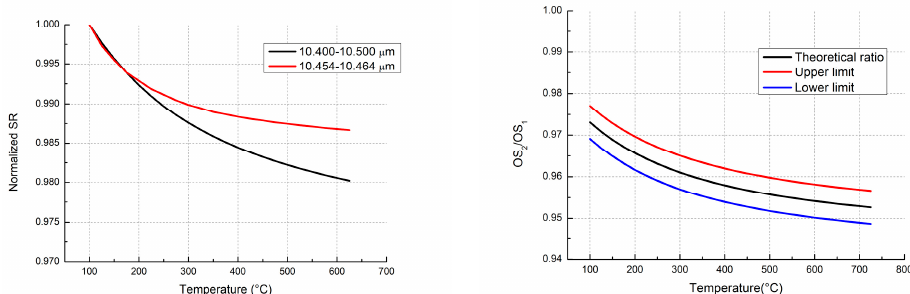
Figure 4. On the ( left ) side, the simulated SR trend is shown for 10.454 μ m and 10.464 μ m filters and for 10.400 μ m e 10.500 μ m. On the ( right ) side, the dispersion is shown for the last couple of filters [6].